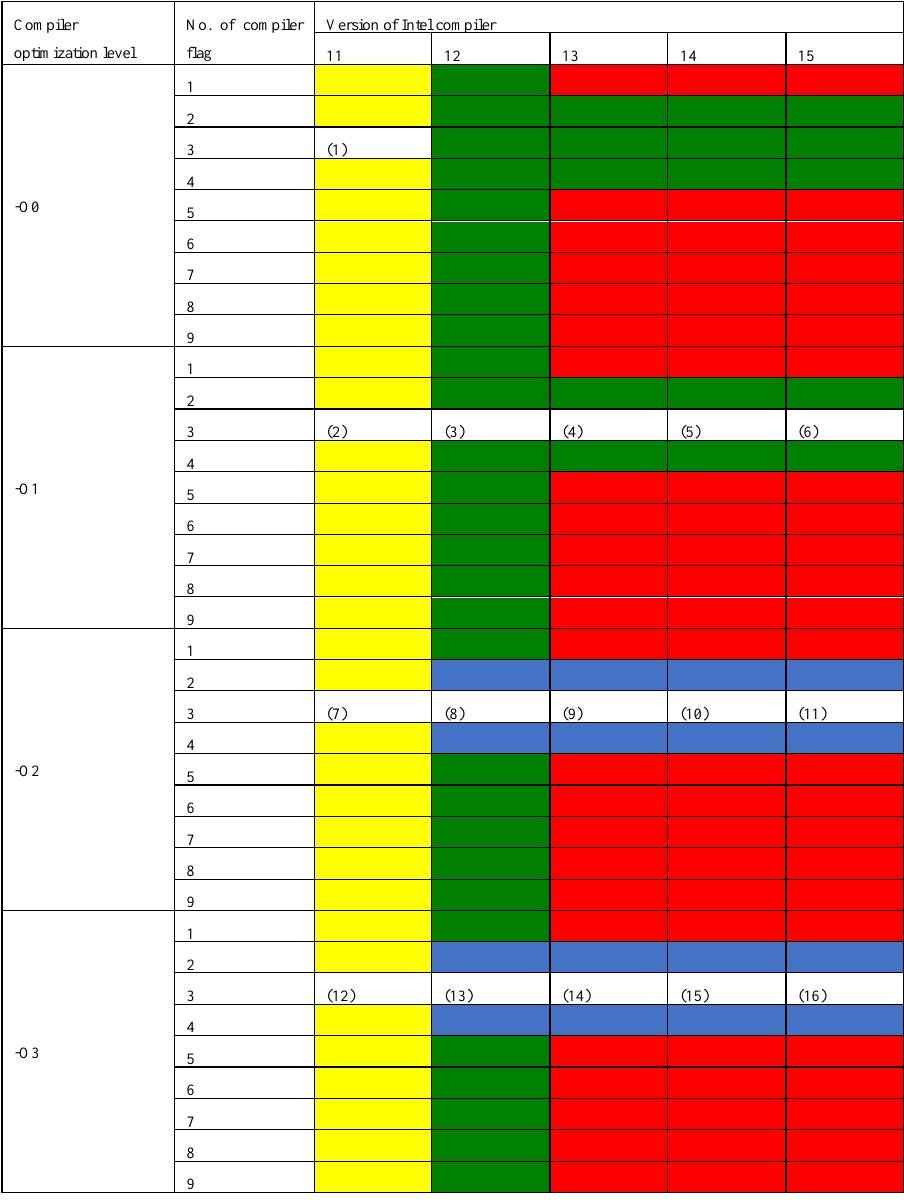
Table 8: Simulation results of CAM5 with various compiling setups of Intel compilers. The compiler flags are given in Table 6. Each color represents a bitwise identical result except for the white. A simulation result that emerges only once is in white color with a unique number.